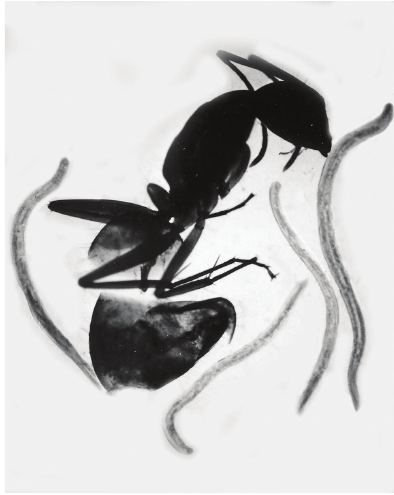
Figure 19: Adults of Rabbium paradoxus adjacent to their ant host, Camponotus castaneus, in Florida.